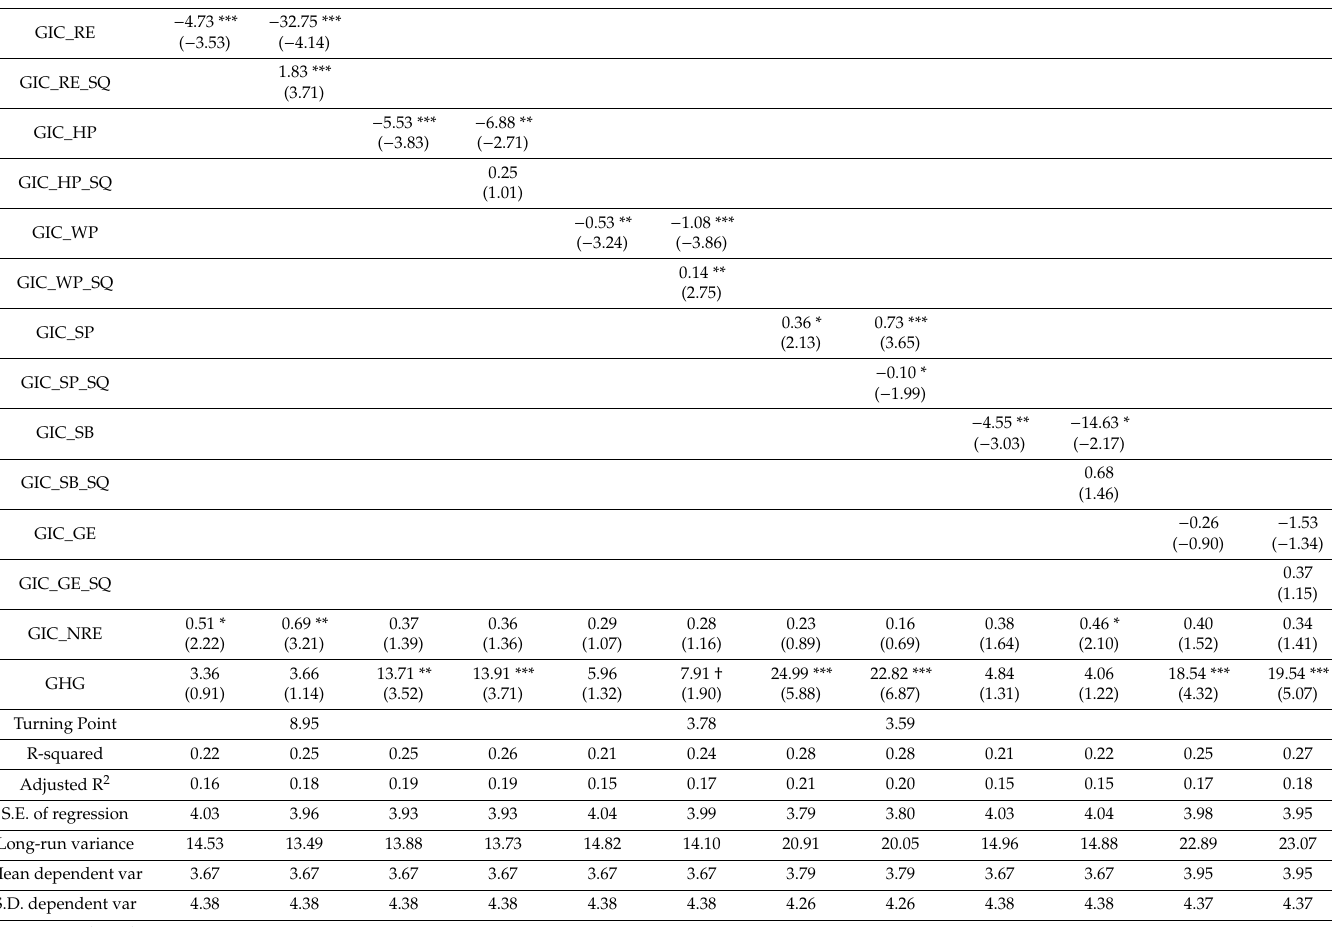
Table 14. Panel long run FMOLS